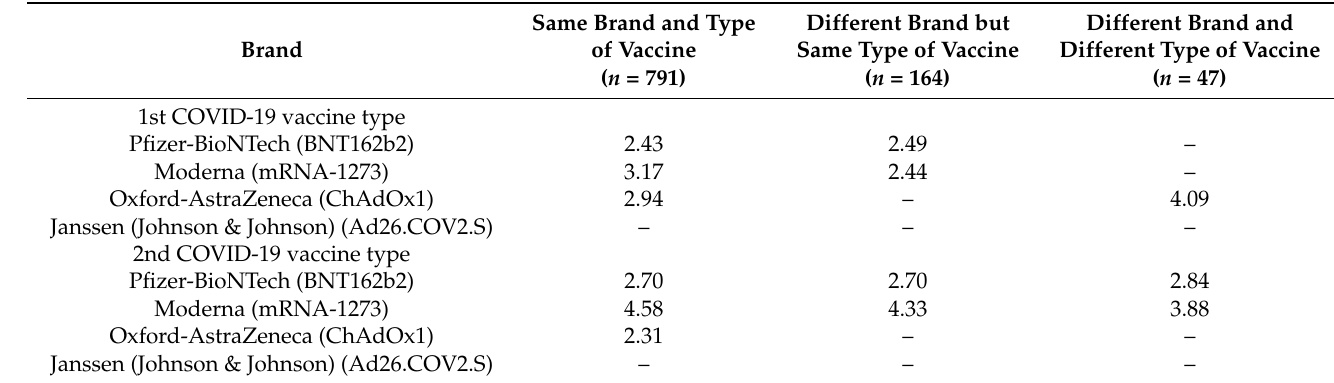
Table 4. Total average amount of self-reported side effects after each vaccination by brand of vaccine ( N =